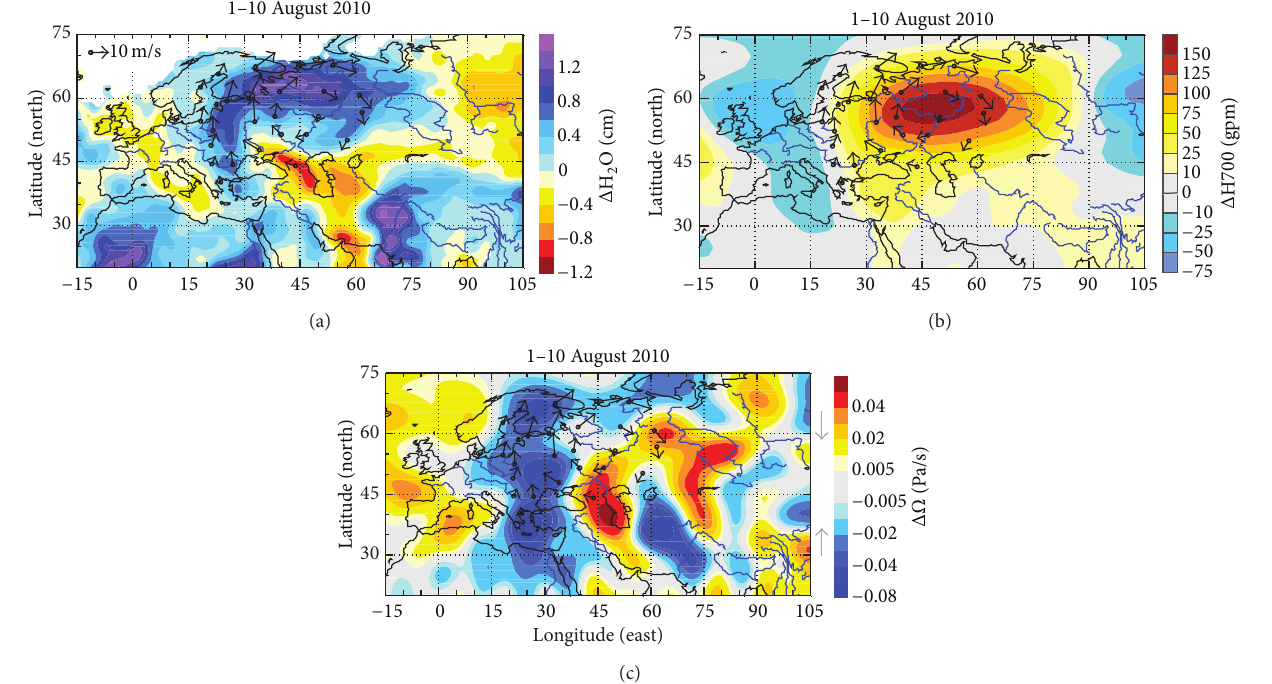
Figure 2: Differences between averages in the period 1–10 August 2010 and averages in the period 1–10 August 2000–2009 for TCWV (a), 700 hPa height (b), and vertical velocity (c). Arrows represent the mean wind vectors at 700 hPa (taken from